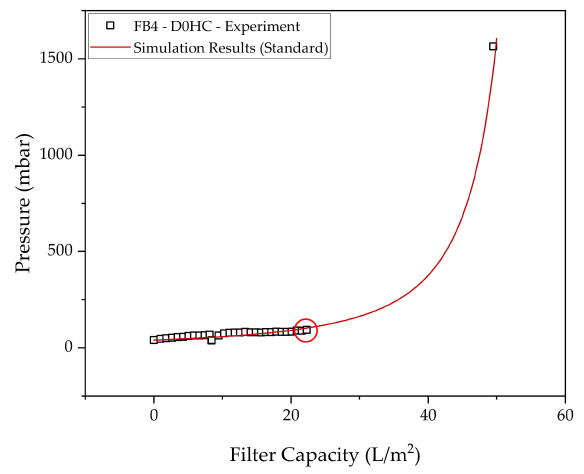
Figure 7. Data points used for the regression to determine the blocking constant and the modeling via the standard blocking model resulting from the parameter determination.